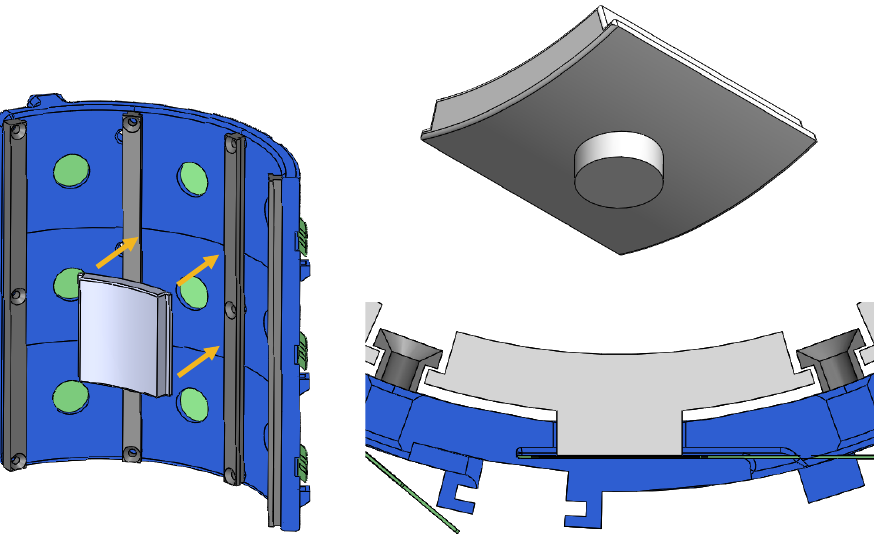
Figure 4. Integration of a single panel (white) installed in the sensorized cuff (blue) shows how it interfaces with the FSR (green) through a puck design. The divider rails (gray) keep the panels from falling